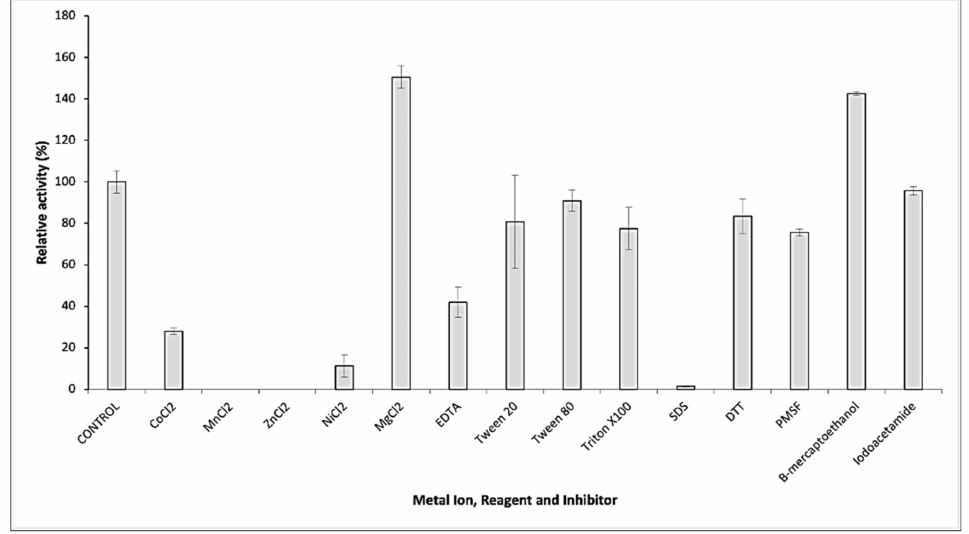
Figure 6. Effect of metal ions, reagents, and inhibitors on the activity of purified Ga PIP. The relative activity of the unincubated enzyme without metal ions, reagents, and inhibitors (control) was taken at 100%. The error bars represent the standard deviation ( n =